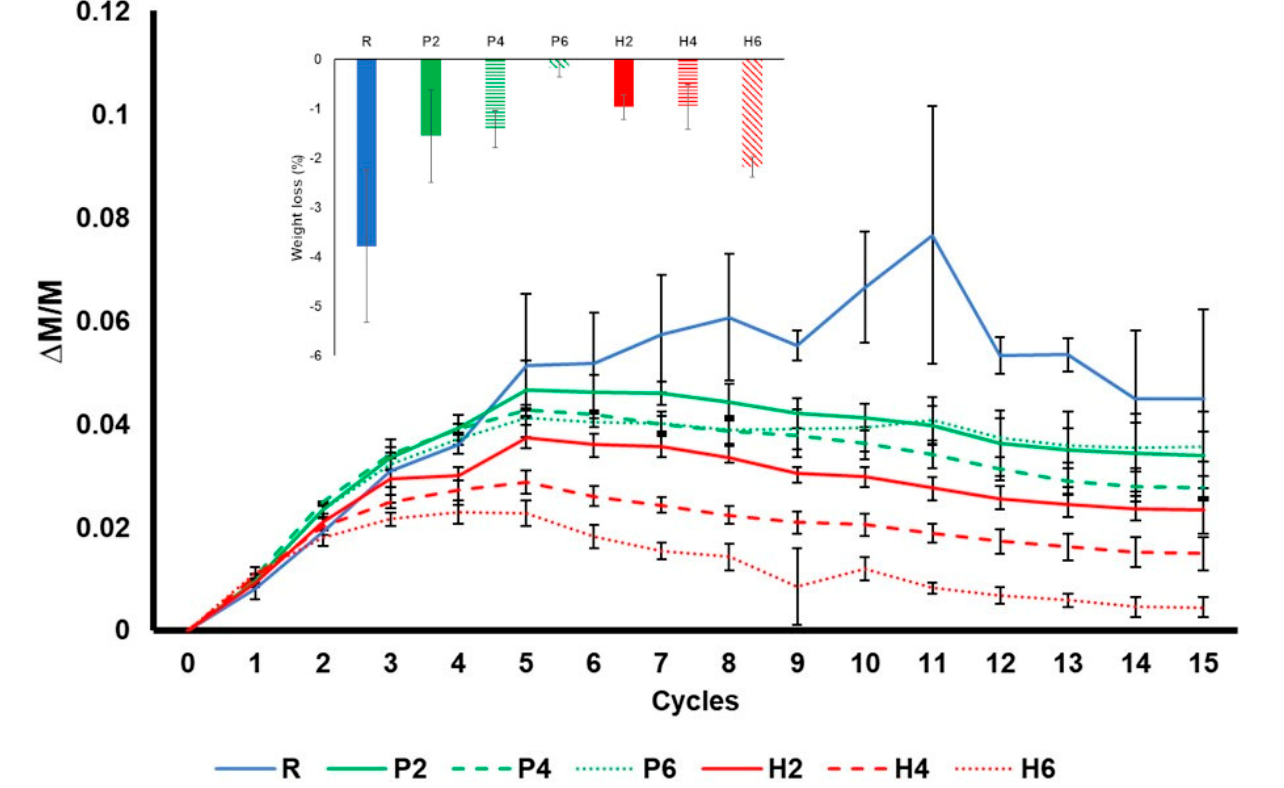
Figure 11. Weight variation in the bricks without additives (R), with EPS (P) and with olive stones (H) over 15 cycles of the salt crystallisation decay test. Each cycle represents 24 h, and each curve is a mean of 3 measurements. The error bars represent the standard deviation. The bar chart above shows the weight loss in the samples at the end of the test.